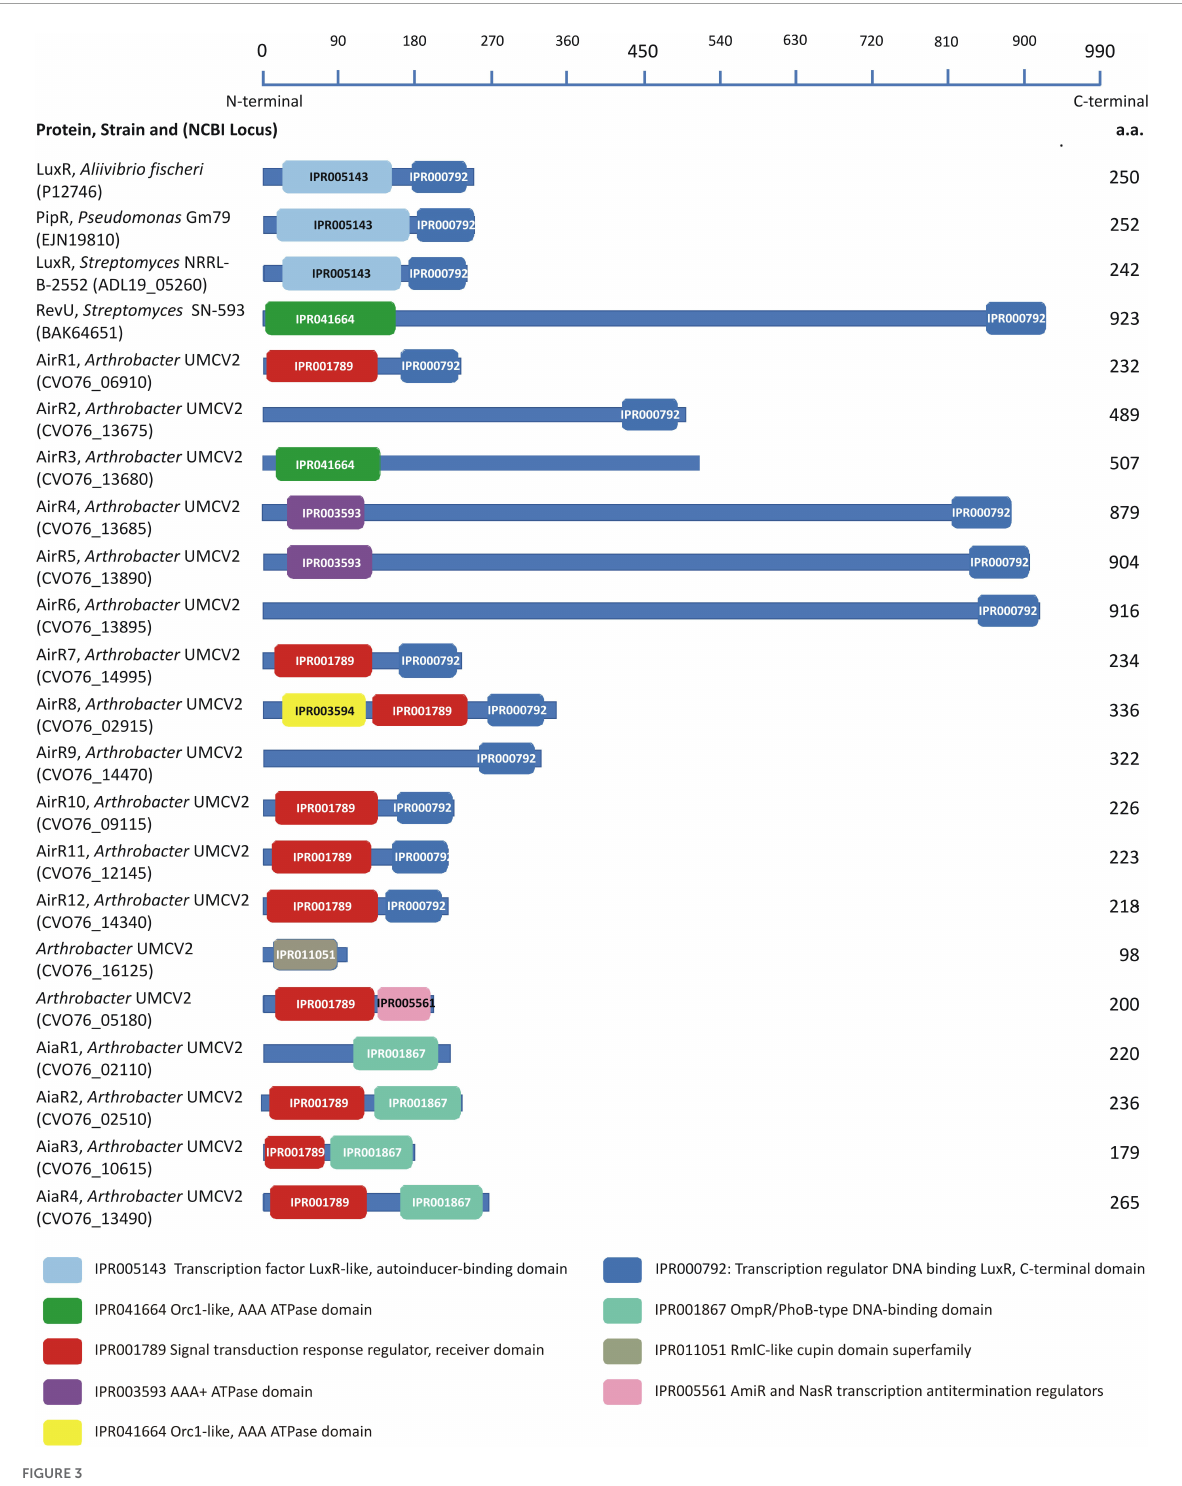
FIGURE3 Conserved domains found in the model LuxR proteins and LuxR-related sequences from Arthrobacter sp. UMCV2. LuxR-related sequences were localized to the genome of Arthrobacter sp. UMCV2 employs the informatic tools MG-RAST 4.0.3 and PATRIC 3.6.12. Domains were localized in the protein sequences employing the informatics tool InterPro v62.0. Proteins are represented with a blue line and their lengths are compared with the upper scale. Conserved domains are localized in the proteins with colored boxes. Protein names, the strain of origin, and national center for technology information (NCBI) locus are indicated in the left